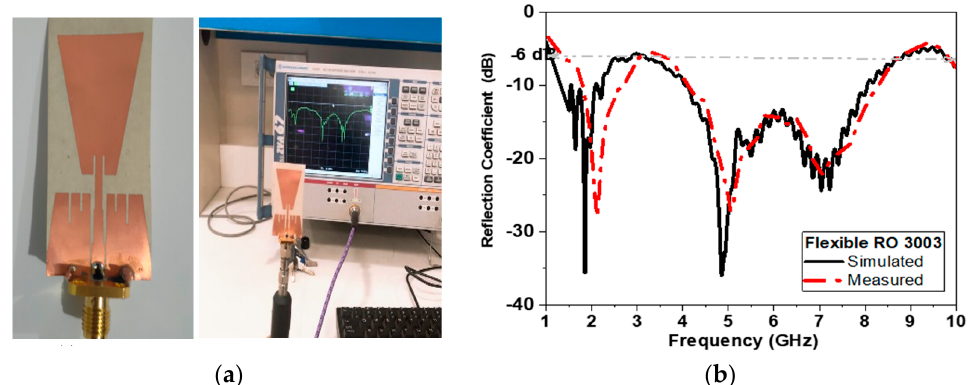
Figure 12. ( a ) Photo of fabricated antenna-based sensor using copper conductor tape and ( b ) meas- ured and simulated reflection coefficient in dB versus frequency.